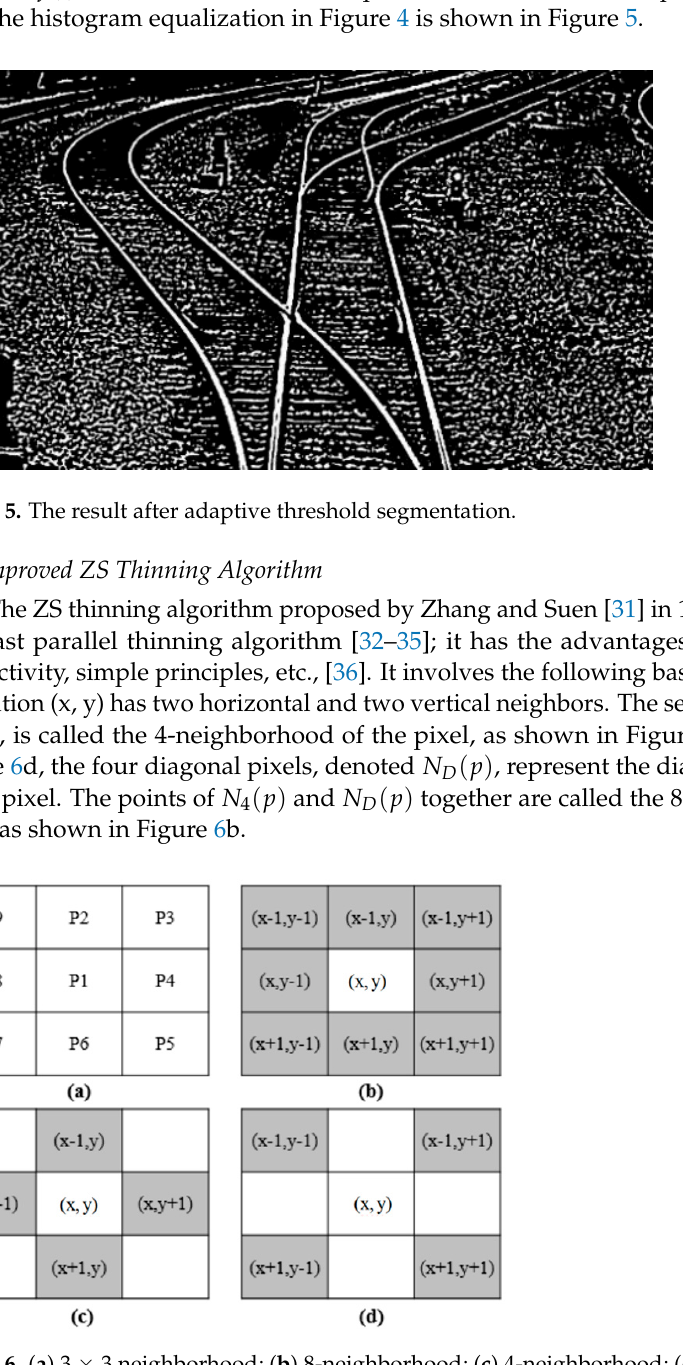
Figure 6. ( a ) 3 × 3 neighborhood; ( b ) 8-neighborhood; ( c ) 4-neighborhood; ( d )